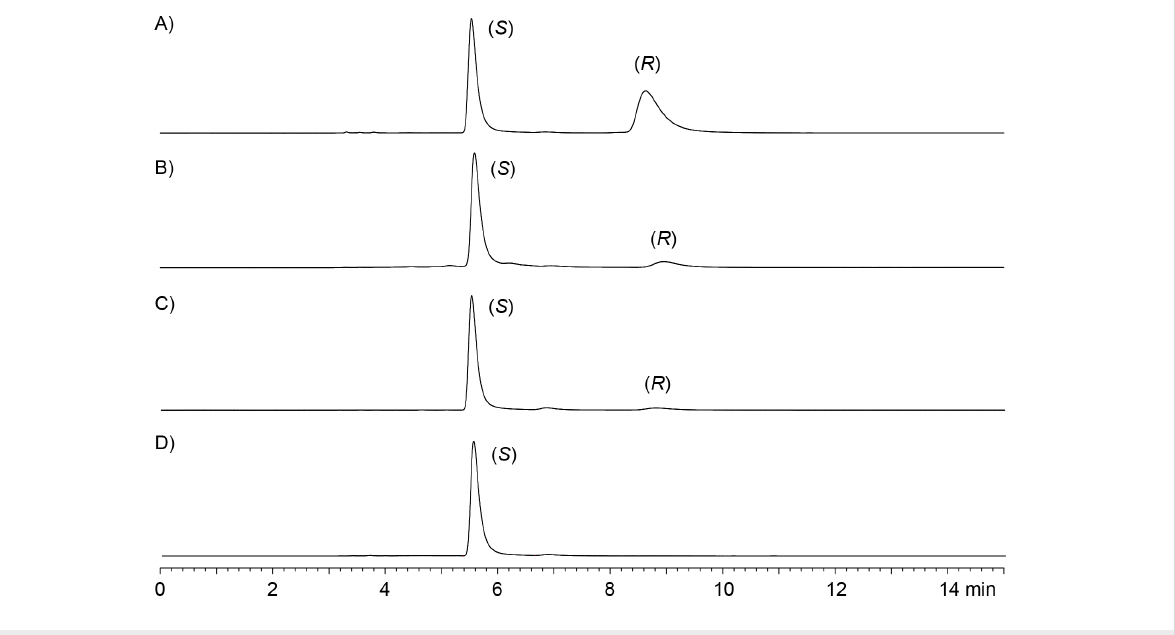
Figure 1: HPLC analyses of ( Z )- 4 on a chiral stationary phase. A) Nearly racemic 4 from the first synthetic route (Scheme 2), B) enantiomerically enriched 4 (80% ee) from the second synthetic approach (Scheme 3), C) enantiomerically enriched 4 (90% ee) obtained under optimised